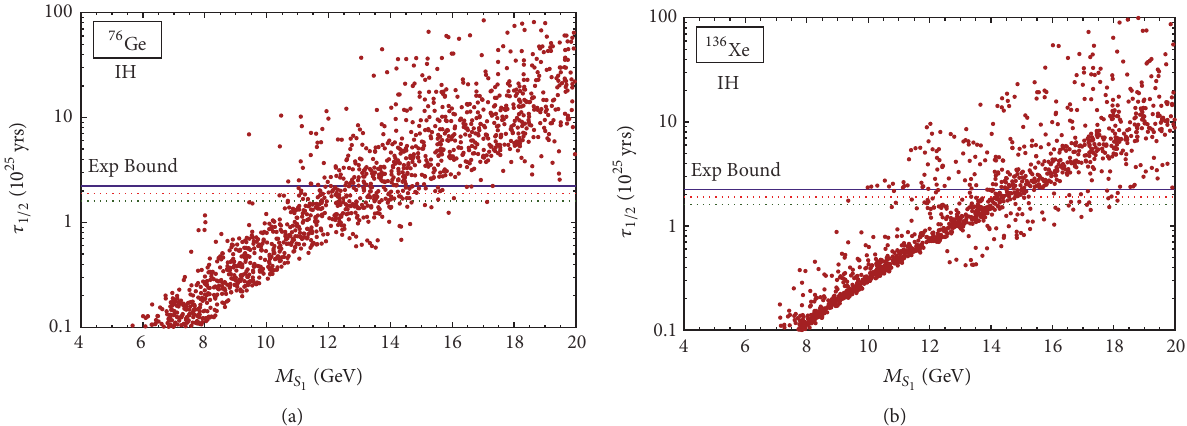
Figure 5: Same as Figure 4 but for inverted hierarchy (IH) of light neutrino masses.